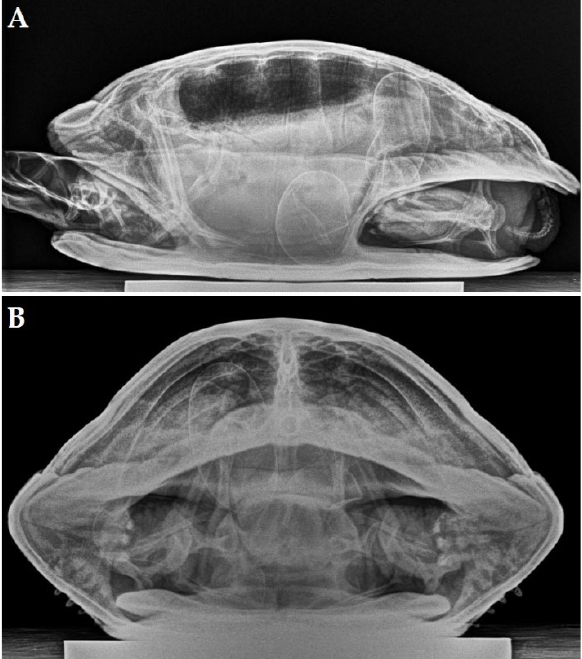
Figure 2. Laterolateral ( A ) and craniocaudal ( B ) radiograph (horizontal beam) of a yellow-bellied slider ( Trachemys scripta scripta ) revealing the presence of 4 ectopic eggs with 3 eggs that have a well-mineralized but thin shell and an abnormal shape. The fourth egg has an abnormally small size. The long axis of the most caudal, large egg showed a vertical position and is located in the right caudal coelomic cavity cranial to the pelvis inlet.